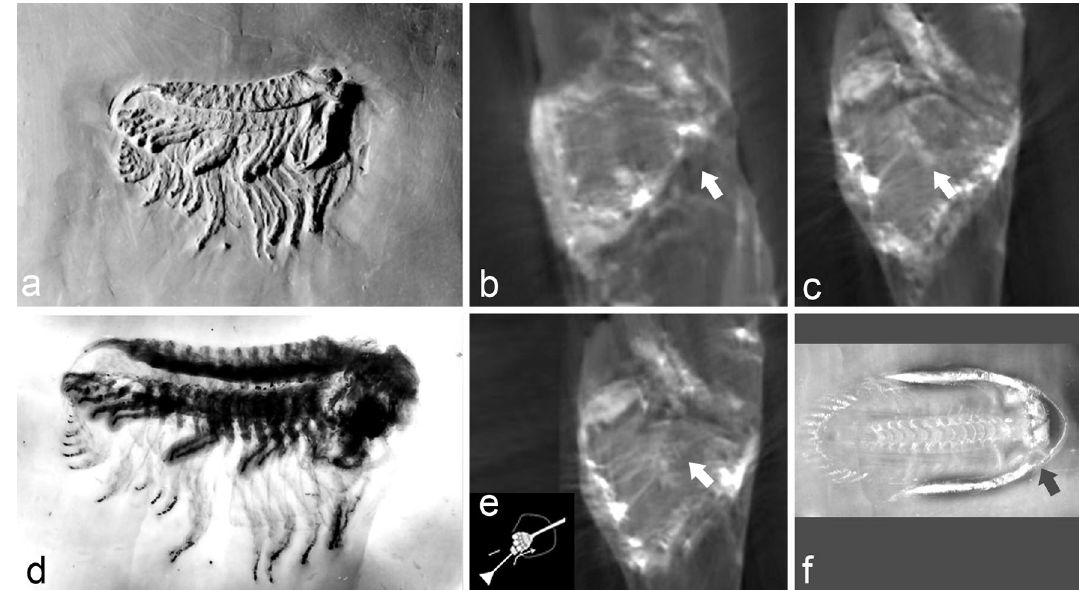
Figure 2. Interior structure of the eye capsule. ( a ) Chotecops ( Phacops ) ferdinandi (Kayser, 1880).WS 295 (SNSB-BSPG 1930 III 8). ( b ) ct of the right eye of a), note the tube at the distal end of the capsule (arrow). ( c ) Deeper section of ( b ), note the ’cube’-like structures below the ’ fibers ’. ( d ) X-ray of ( a ), made by Stürmer. ( e ) Deeper section of ( c ), note the hierarchically ordered spherical structures (arrow) below of the ’cubes’ as shown in ( c ), and the filamentous structure distally. ( f ) Asteropyge ( Rhenops ) sp. (WS 2236), showing an eye capsule (arrow), [this specimen was not provided with any